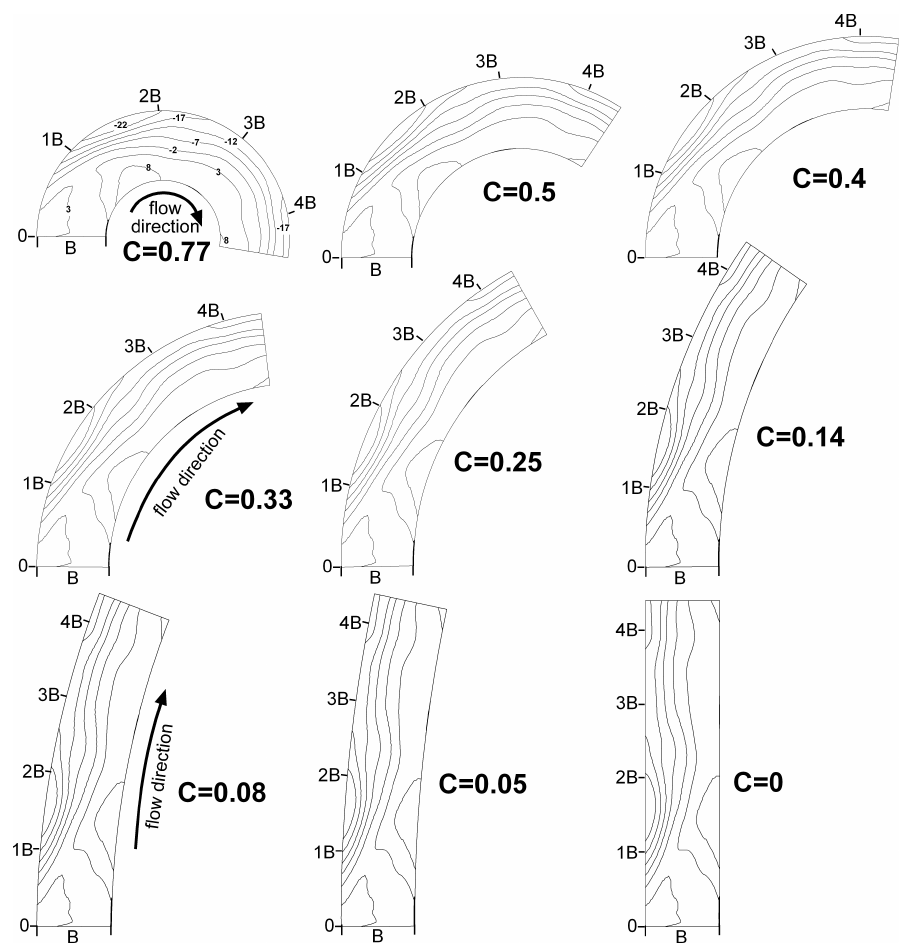
Figure 1. Geometries and bed topography settings of the nine computational fluid dynamics (CFD) simulations with channel curvature ( C ) changed from 0.77 to